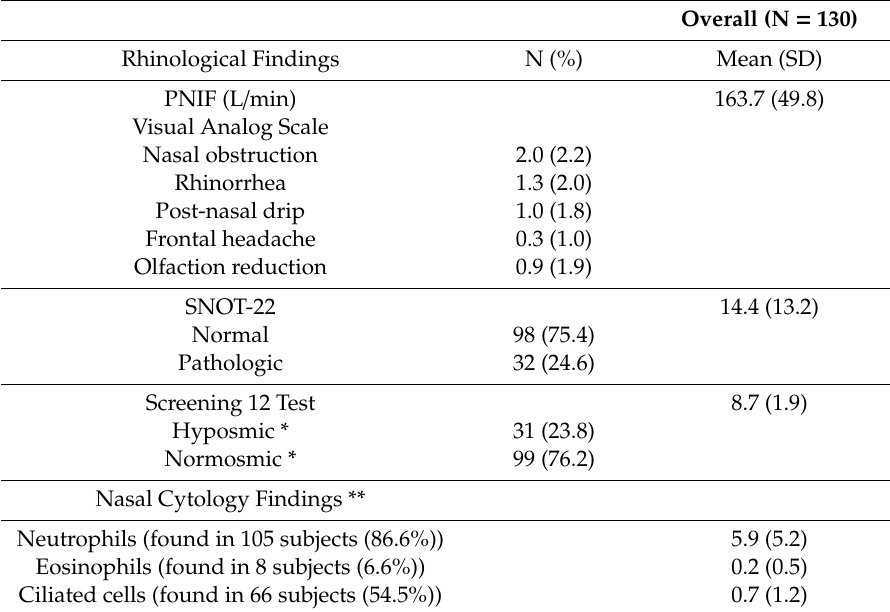
Table 4. Main upper respiratory results.